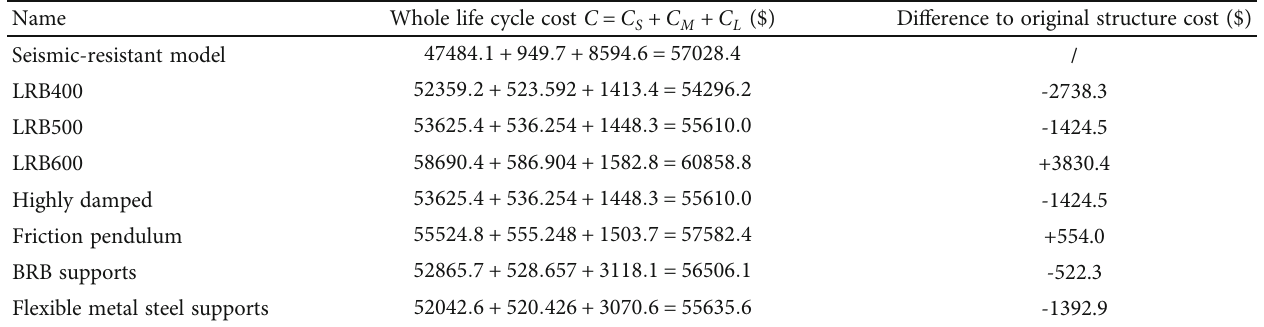
Table 9: Life cycle cost of each